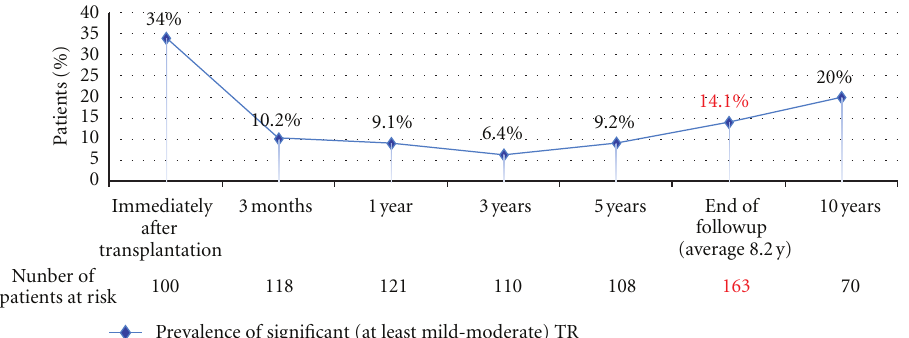
Figure 1: Prevalence of significant (at least mild-moderate) tricuspid regurgitation (TR) at di ff erent time points.